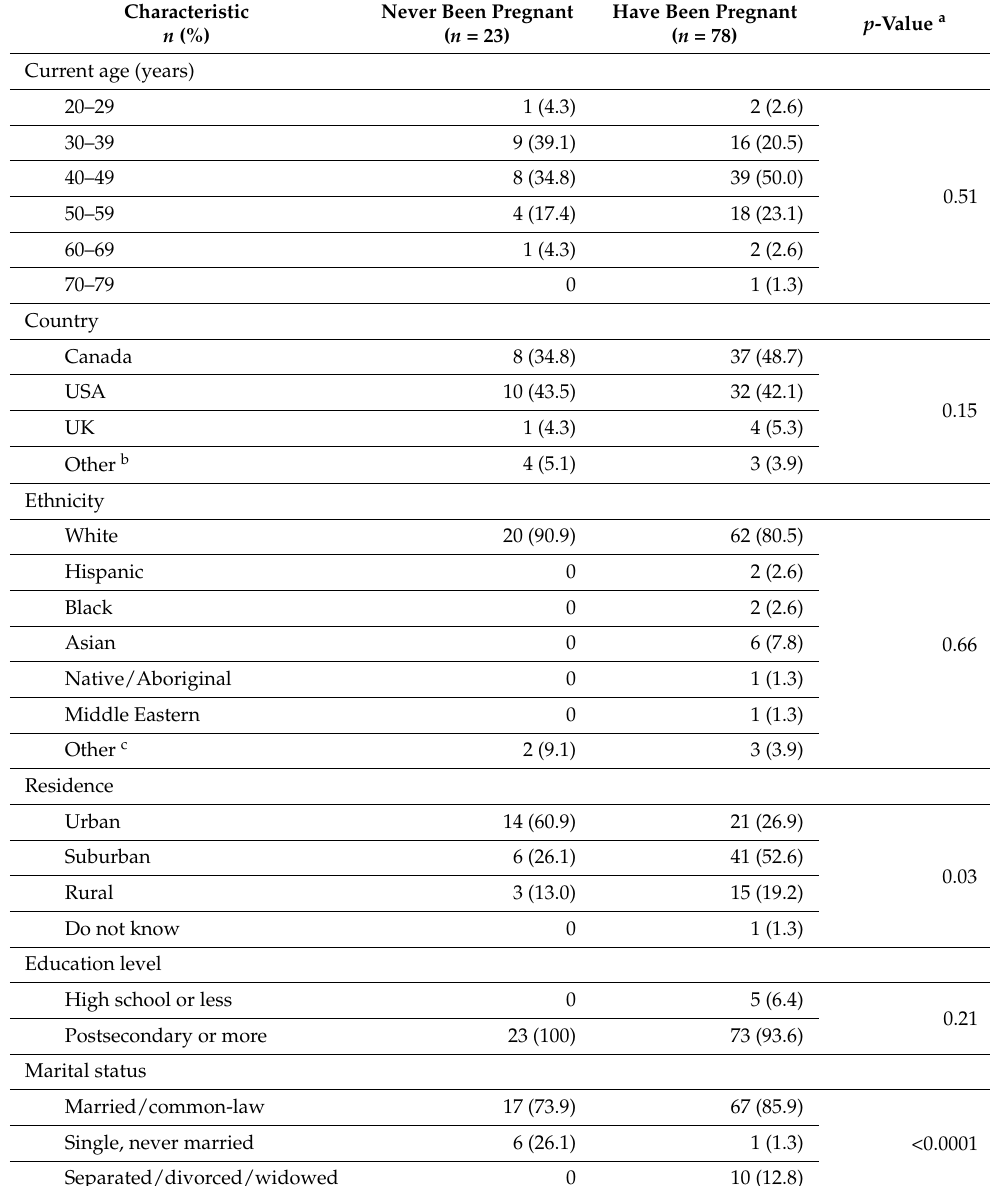
Table 1. Participant demographic characteristics according to pregnancy history.